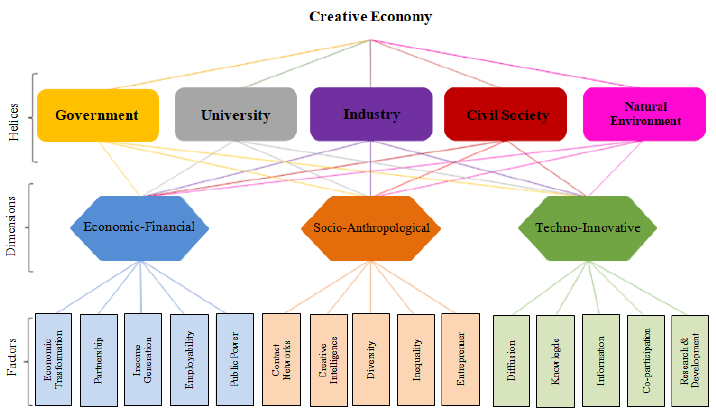
Figure 5. Creative economy graphic representation in relation to quintuple helix innova- tion model/helix model of innovation, their dimensions and criticality factors (source: created by